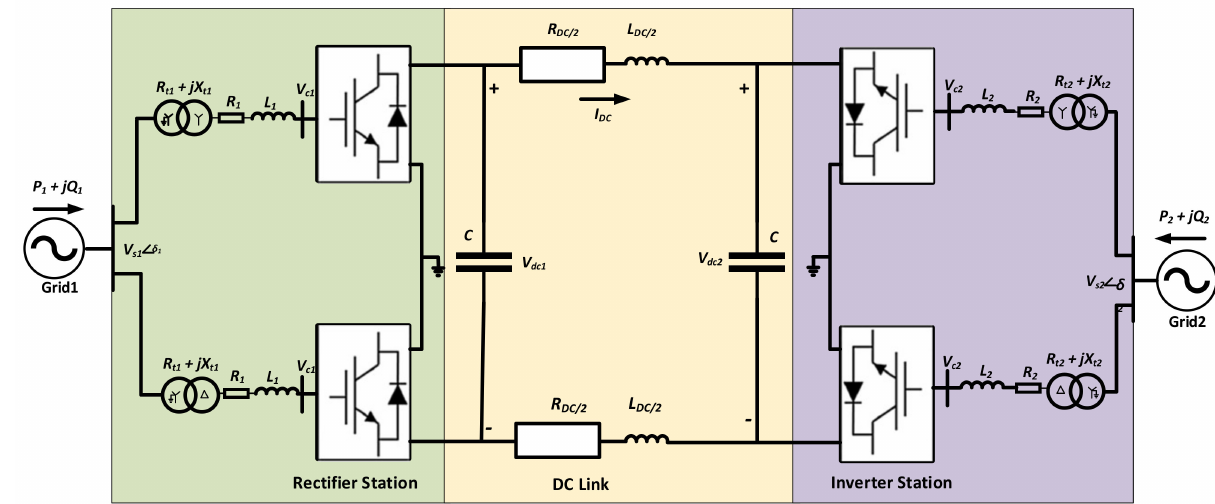
Figure 1. Schematic representation of VSC HVDC